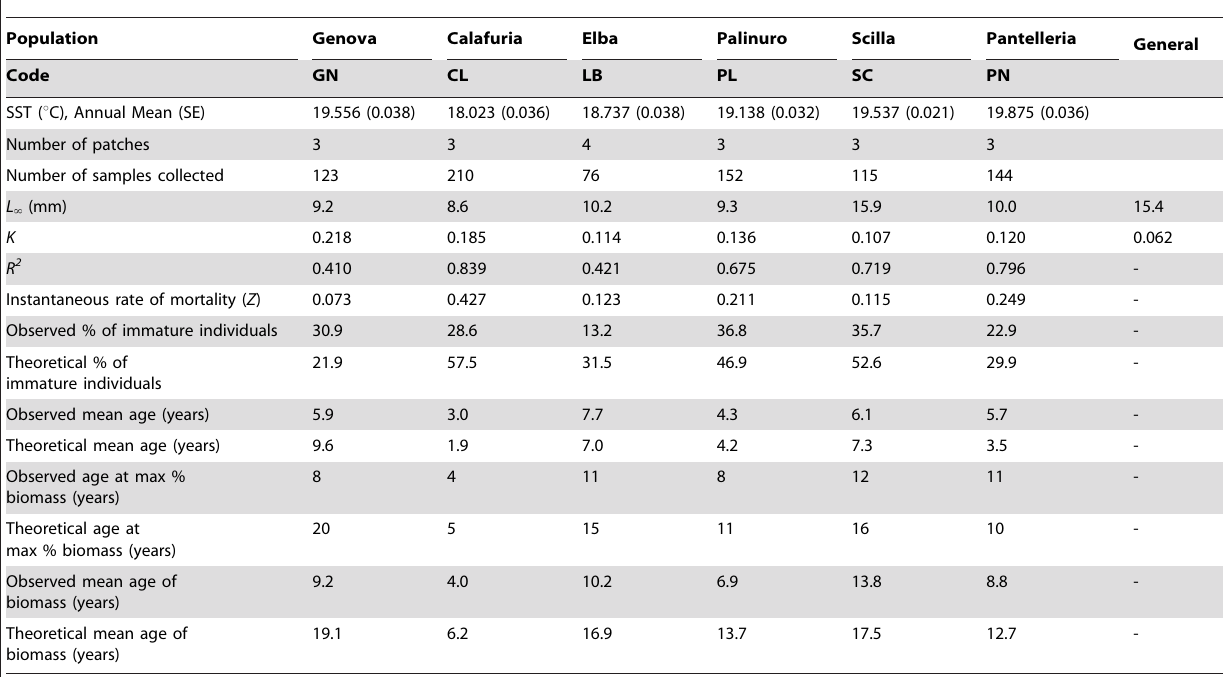
Table 1. Sea surface temperature, number of patches and collected samples, L ‘ , K , r 2 (coefficient of determination of the semi-log regression of Eq. 2, which is an estimator of population structure stability) and demographic parameter values of each sampled